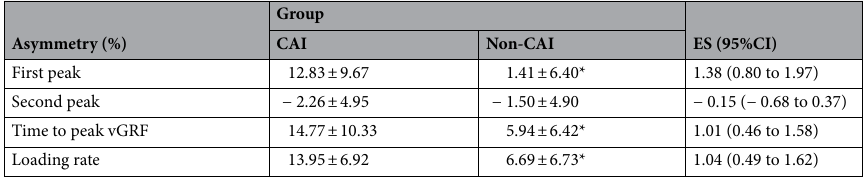
Table 2. Mean ± SD, effect size (ES) and 95% confidence interval (CI) for vGRF asymmetry between CAI and Non-CAI groups. CAI Chronic ankle instability, vGRF Vertical ground reaction force, ES (95%CI) effect size (95% confidence interval), *Indicates a significant difference from the CAI group (P ≤